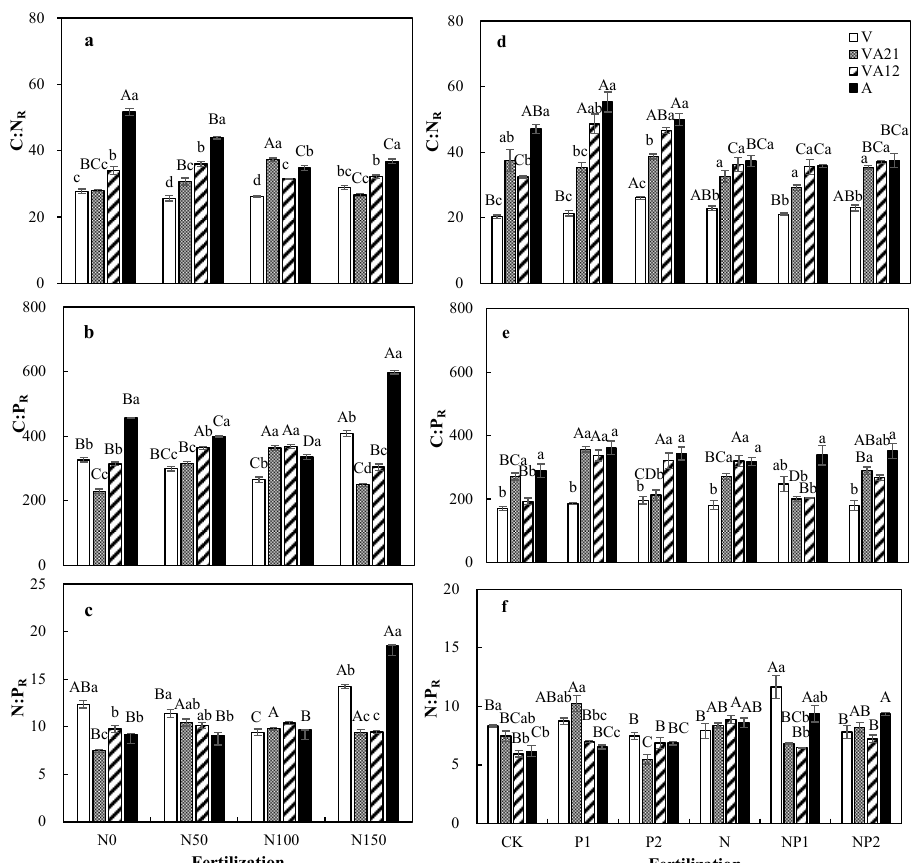
Figure 2. Root C, N, P stoichiometric ratios under different fertilization rates and mixing ratios in 2019 and 2020. ( a – c ) show 2019 data and ( d – f ) show 2020 data. Values are presented as mean ± S.E. ( n = 3). Different capital letters show significant difference among fertilization rates under the same mixing ratio ( p < 0.05). Different lowercase letters show significant difference among mixing ratios under the same fertilization rate ( p < 0.05).